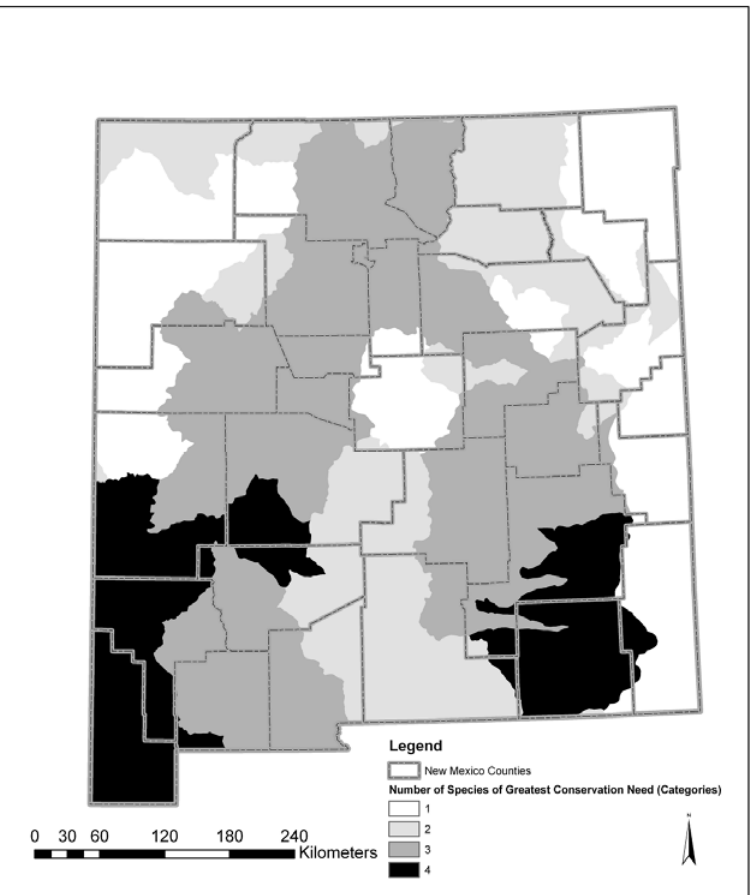
Figure 3. Number of terrestrial and aquatic Species of Greatest Conservation Need by 4-digit Subbasins in New